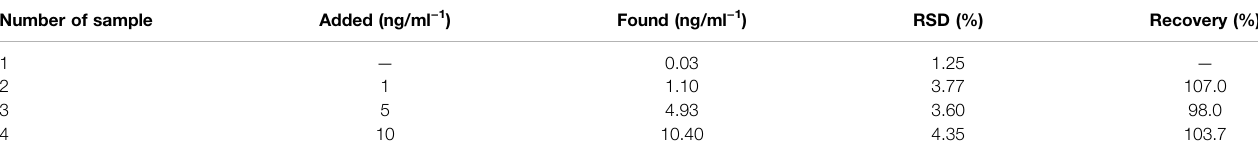
TABLE 2 | Determination of added HER2 to human blood serum. Number of sample Added (ng/ml − 1 ) Found (ng/ml − 1 ) RSD